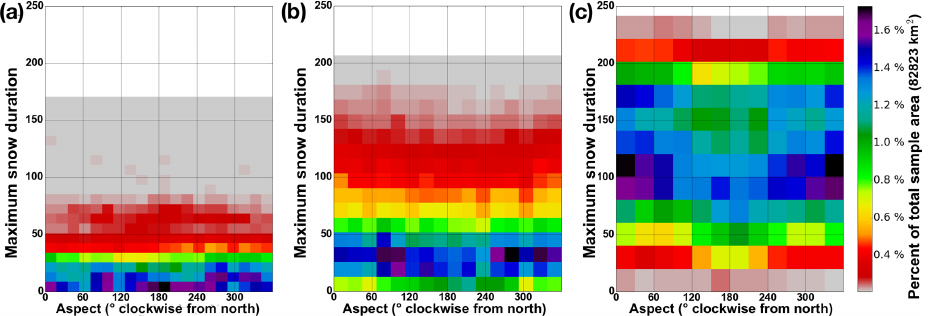
Figure 9. Heat maps of the relationship between aspect and average maximum consecutive snow duration (maximum snow duration) at (a) low elevations (0–1500m), (b) medium elevations (1500–2500m), and (c) high elevations (2500m +